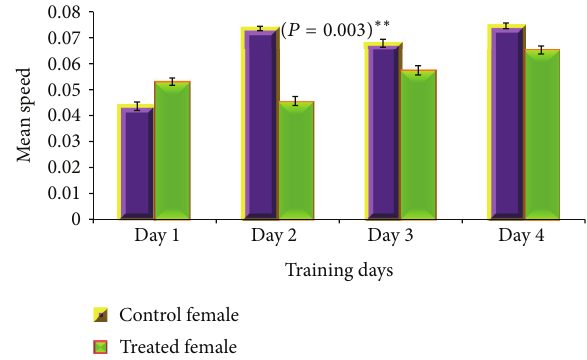
Figure 4: Comparison of mean speed by GABA B antagonist and saline treated female albino mouse during acquisition phase of Morris Water Maze test. Data is expressed as mean ± standard deviation. 𝑃 value indicates the result of 2-sample 𝑡 -test for the specific training